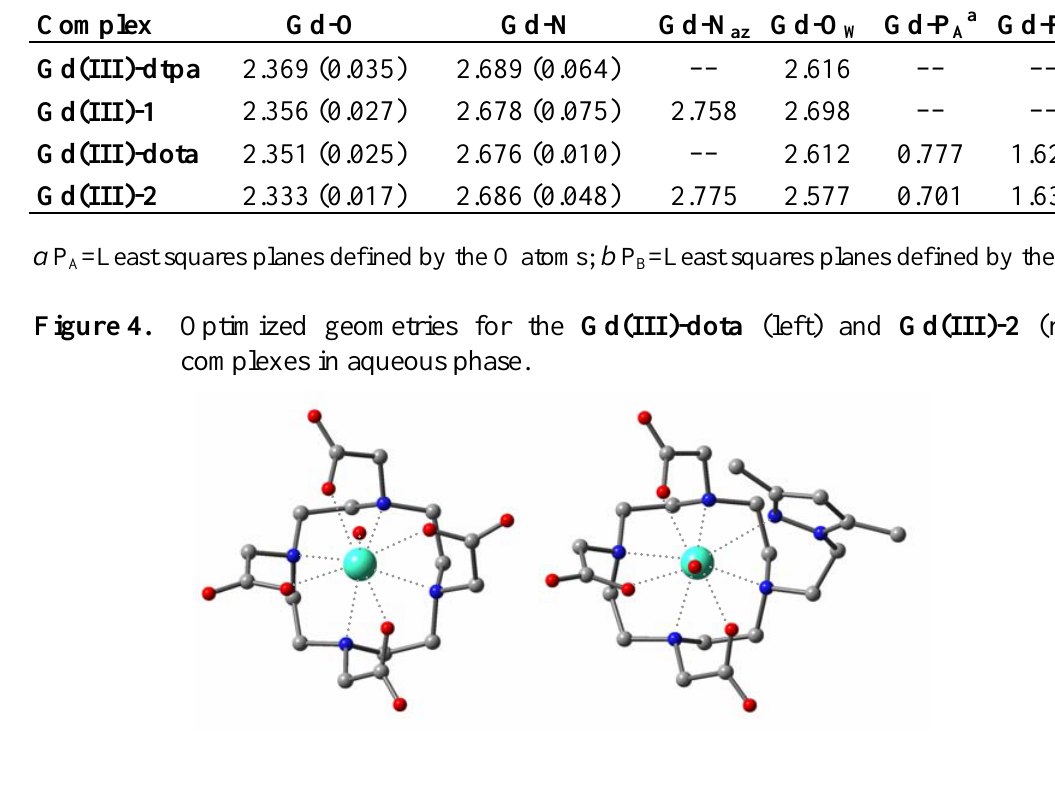
Table 2. Mean distances (Å) and standard deviations (in parenthesis) from theoretical O)]n– complexes in aqueous phase. calculations of [Gd-L(H 2